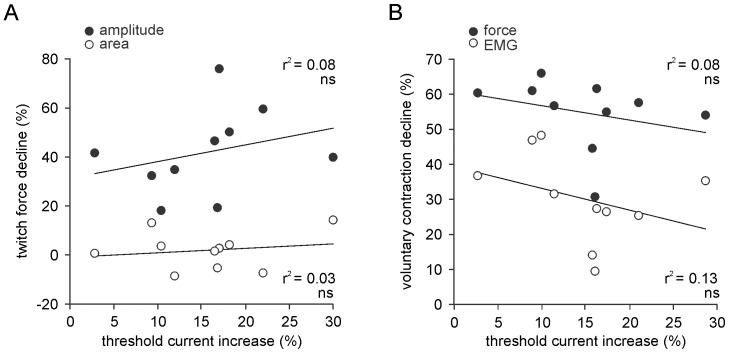
Relationship between the activity-dependent changes in muscle output and axonal excitability.Symbols represent the mean for each subject across 5 experimental sessions. A: There was no relationship between the activity-dependent increases in threshold current and the decline in the amplitude (black symbols) or area (white symbols) of resting twitch force. B: Similarly, there was no relationship between increases in threshold current and the decline in voluntary force (black symbols) and voluntary EMG (white s). ns: not significant.